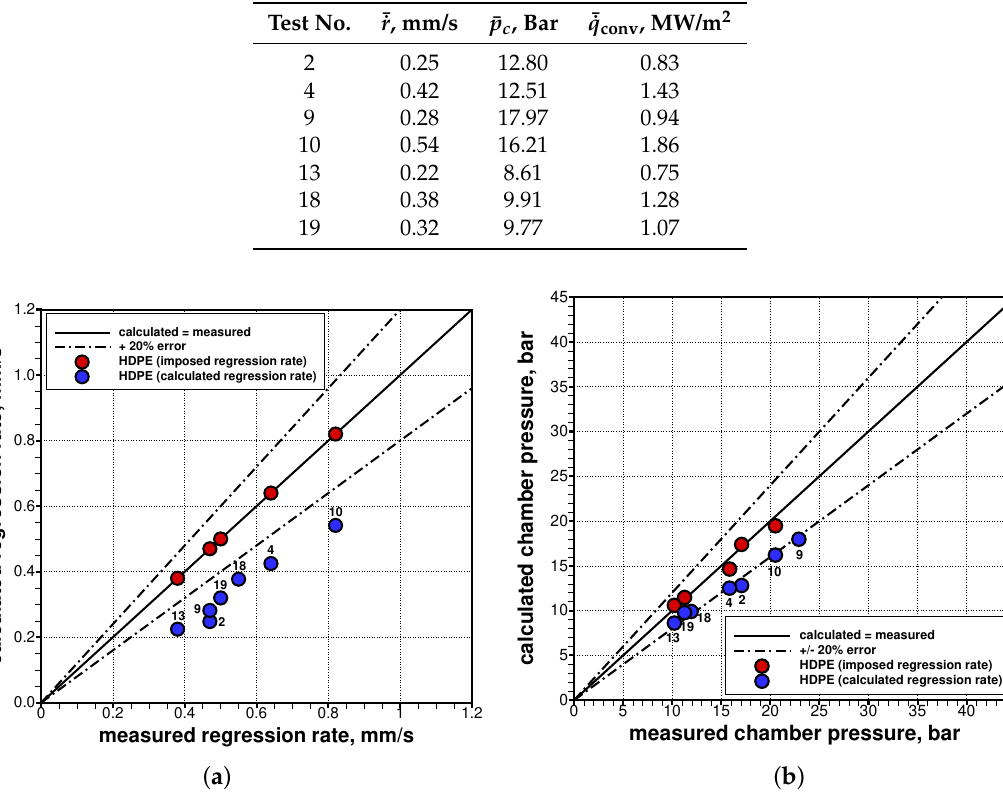
Figure 8. Comparison of computed values from simulations (with the calculated or imposed regression rate) with measured data from the experimental firings: ( a ) time- and space-averaged regression rates; ( b ) time-averaged chamber